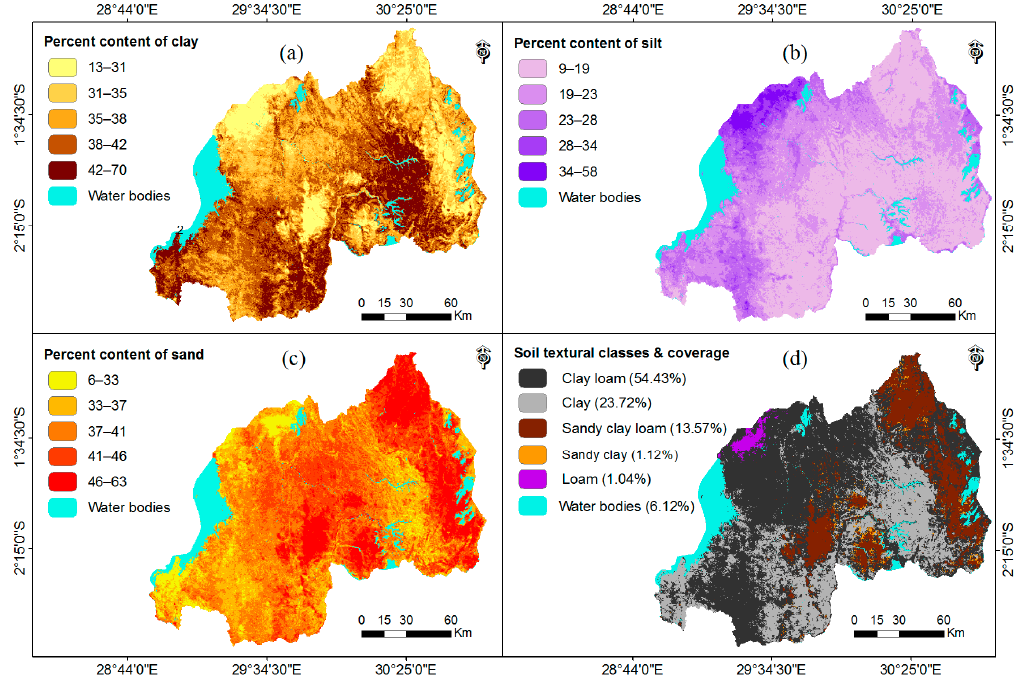
Figure 6. Percent content of: ( a ) clay; ( b ) silt; ( c ) sand and ( d ) soil textural classes for Rwanda. Table 3. Soil textural classification using the percent of sand, silt and clay content (adapted from the United States Department of Agriculture (USDA) soil texture triangle [47]).